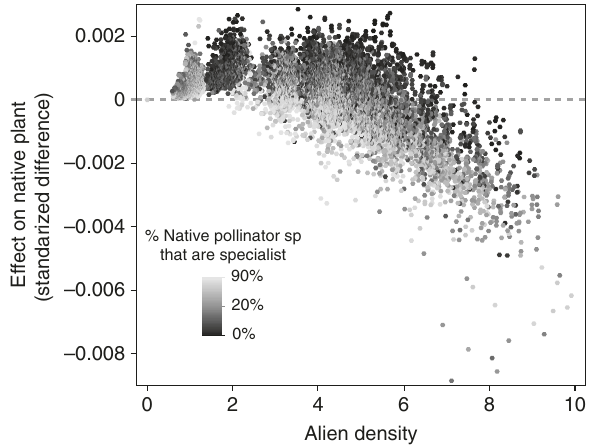
r( e r ff d i ed i z anda r s t